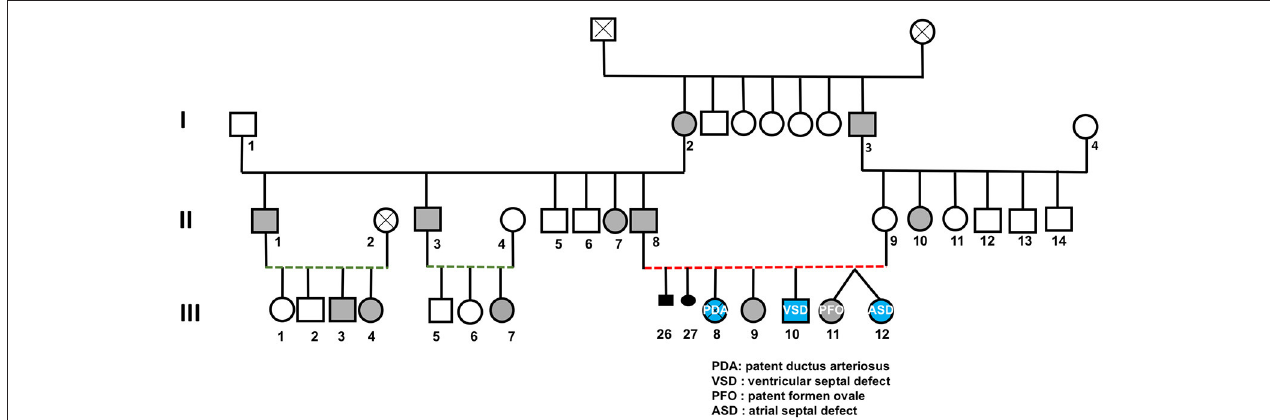
FIGURE 1 | Congenital heart and limb deformities in a large consanguineous Lebanese family. The pedigree shows a three generations’ family (roman numbers) with inherited polydactyly (gray symbols) or congenital heart defects amongst its members (Arabic numbers). Red and green dotted lines indicate first and second degree cousin marriages respectively.